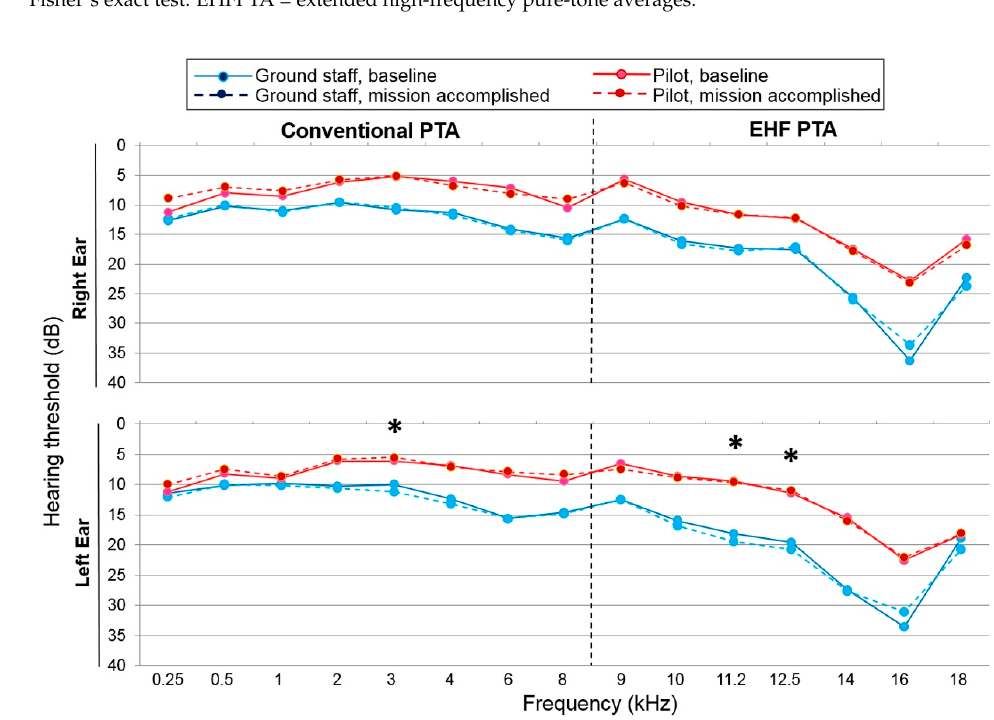
( − 1.5 ± 0.7 dB; p = 0.03) and 6 kHz ( − 1.5 ± 0.6 dB; p = 0.01) in the right ear and at 3 kHz ( − 1.7 ± 0.6 dB; p = 0.01) and 6 kHz ( − 1.8 ± 0.6 dB; p = 0.009) in the left ear (Figure 5).